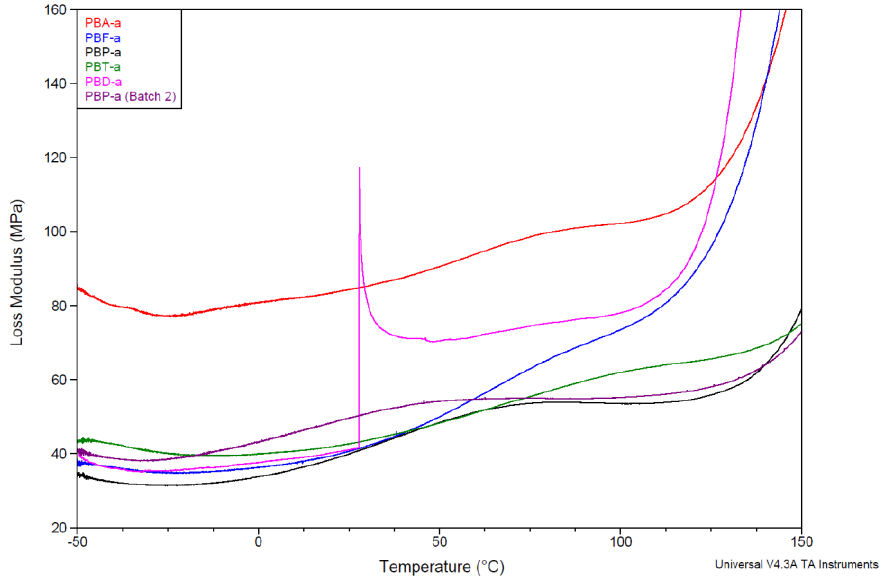
Figure 6. Loss Modulus of PBZs via DMA (2 K/min from − 50 °C to 200 °C at 0.1% strain, 1Hz FF).